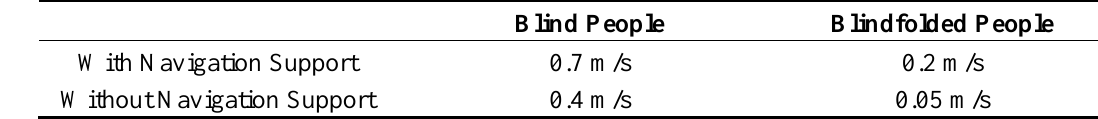
Table 1. Summary of walking